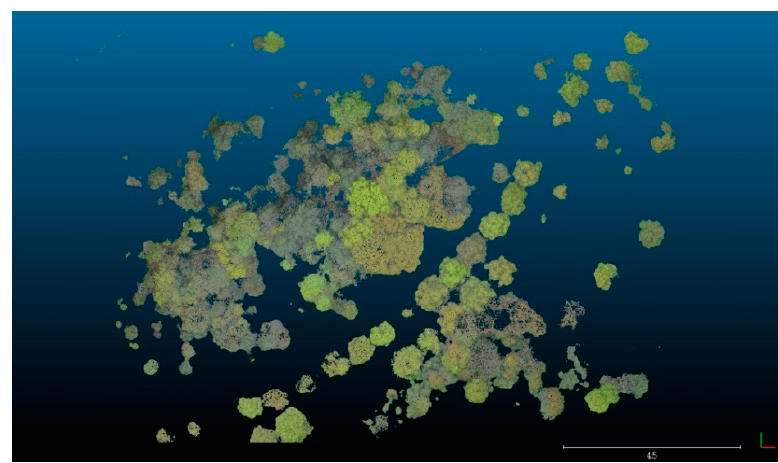
Figure 3. The 3D point cloud model in which near-ground points had been separated